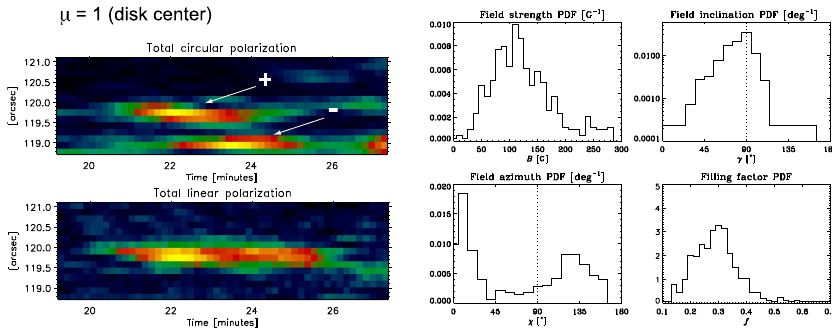
Fig. 36 Small-scale magnetic loop recorded in sit-and-stare deep-mode Hinode/SP observations of the quiet Sun at disk center. Left: Maps of the total circular and linear polarization (top and bottom panels, respectively). Time goes from left to right and spatial position along the slit from bottom to top. The signatures of the loop emerging in the solar photosphere are clearly seen: a conspicuous linear polarization patch flanked by two circular polarization patches of opposite polarity. The linear polarization signal is thought to represent the nearly horizontal loop top and the circular signal the more vertical loop footpoints. Right: Magnetic field PDFs for the structure displayed on the left panels, as derived from a ME inversion of the data. Clockwise from upper left: field strength, field inclination, magnetic filling factor, and field azimuth. Inclinations and azimuths are given in the line-of-sight reference frame. The PDFs have shapes similar to those deduced for the solar IN (Fig. 30), except for the azimuth distribution which reflects the orientation of the vector magnetic field in the loop. Image reproduced with permission from Orozco Suárez and Katsukawa (2012), copyright by